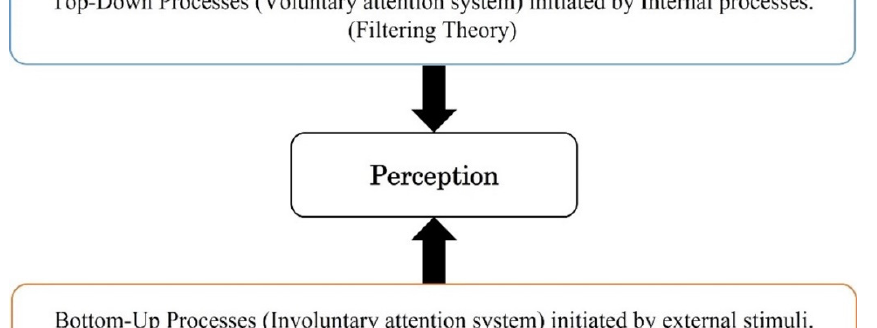
Figure 5. Two attentional systems impact the consumers’